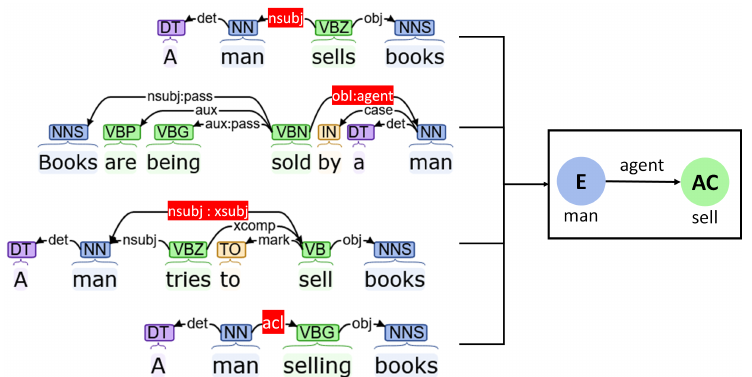
Figure 5. Various ways to create “agent” edges from dependencies.